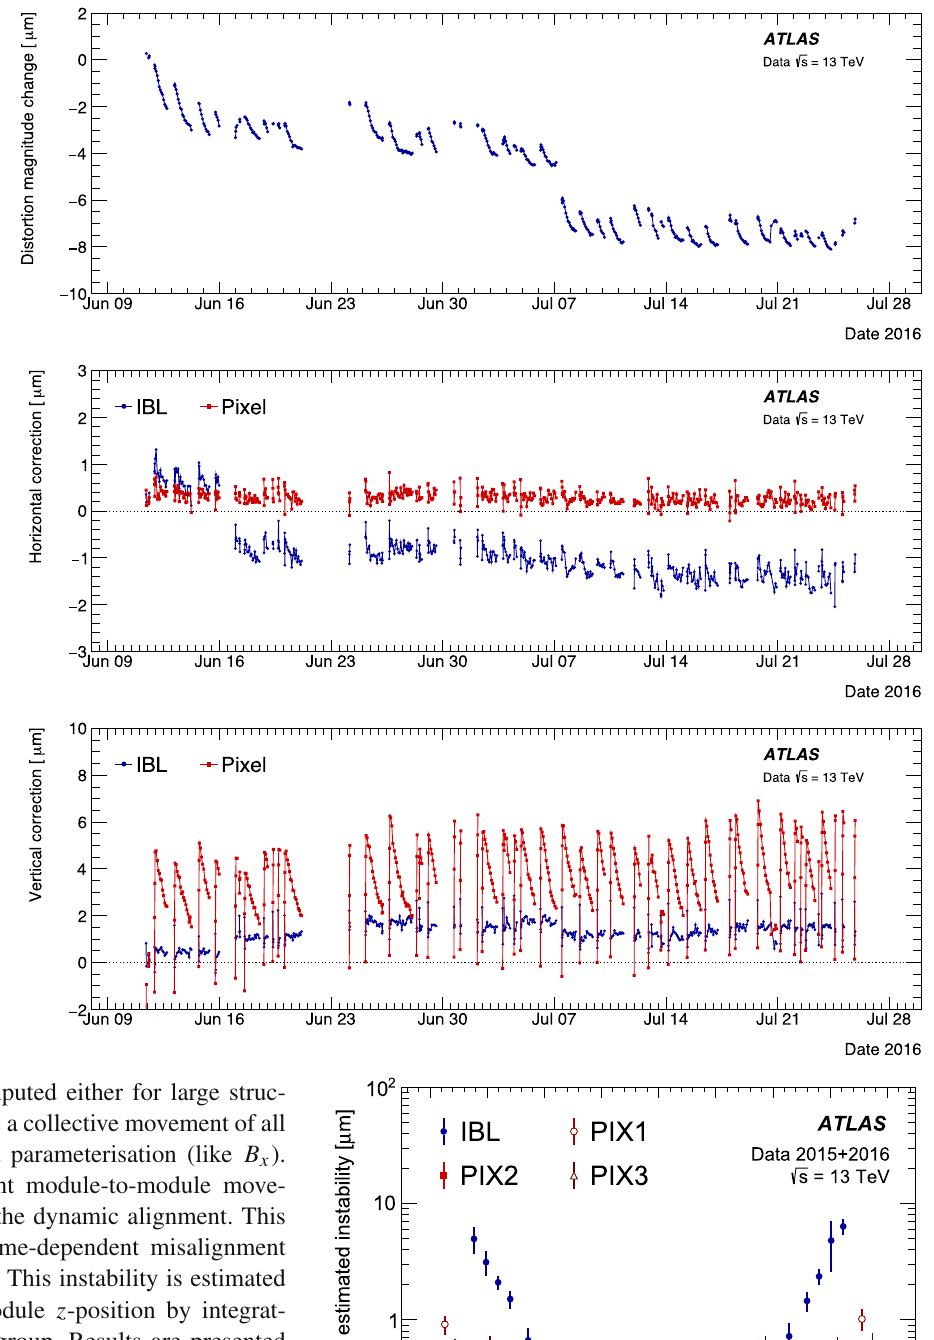
Fig. 13 Estimated σ time x as a function of the module global- z position for the IBL and Pixel barrel layers. The vertical bar on each marker represents the standard deviation of the estimated value over modules at the same z -position along different staves. The global- z position is slightly modified from its true value for visualisation